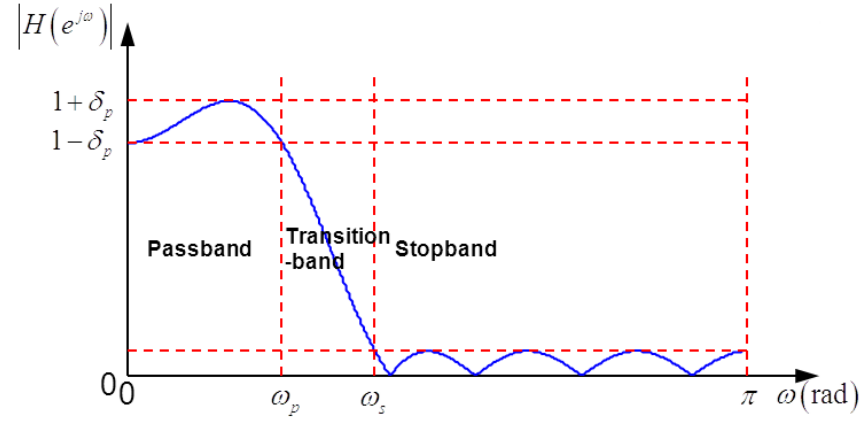
Figure 3. Magnitude response and design parameters of an equiripple low-pass FIR filter.